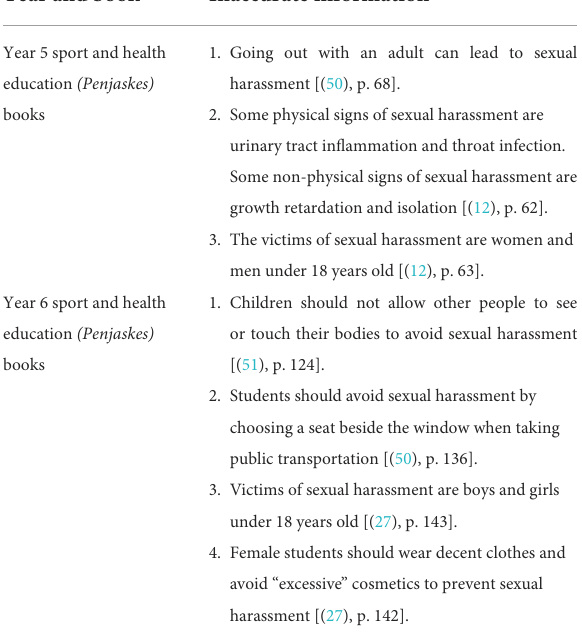
TABLE 4 Some inaccurate information about violence and sexual